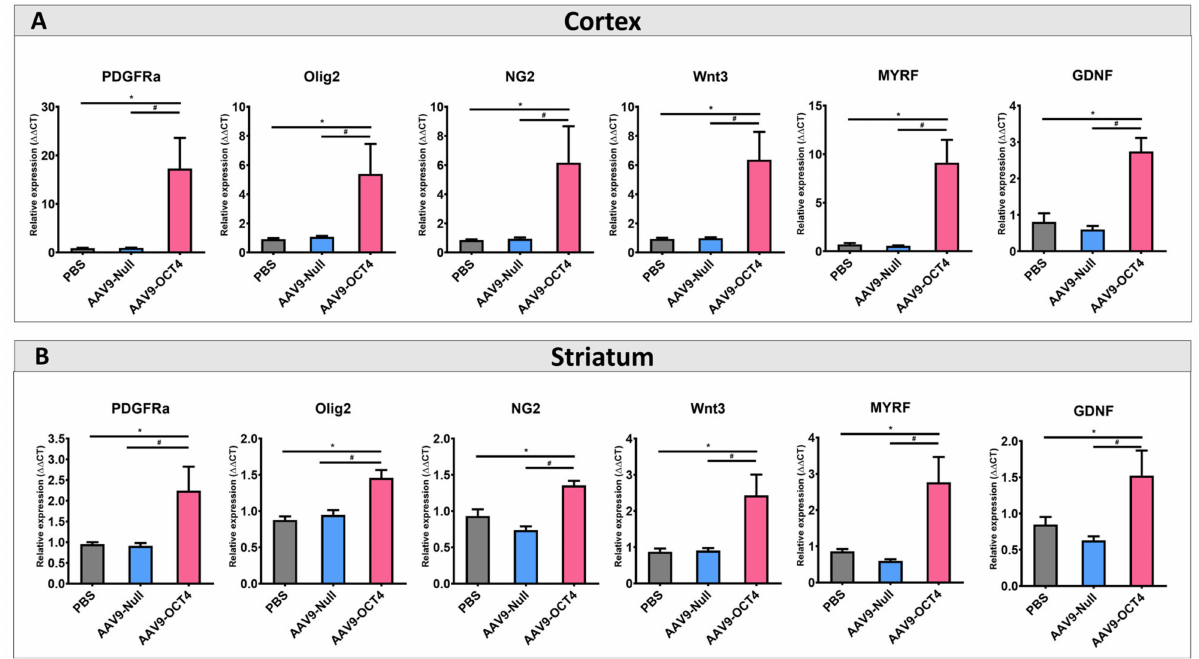
Figure 4. In situ expression of OCT4 increases OPC-related genes. ( A ) To confirm that OPC-related genes proliferation in the cortex ( B ) and striatum among three groups at 13 weeks of age by using qRT-PCR. AAV9-OCT4 group significantly increased expression levels of NG2, Olig2, PDGFRa, Wnt3, MYRF and GDNF in the cortex and striatum *,# p < 0.05, Data in all panels represent mean ± SEM. * PBS vs. AAV9-OCT4, # AAV9-Null vs. AAV9-OCT4. PBS group (N = 4); AAV9-Null (N = 4); AAV9-OCT4 (N =